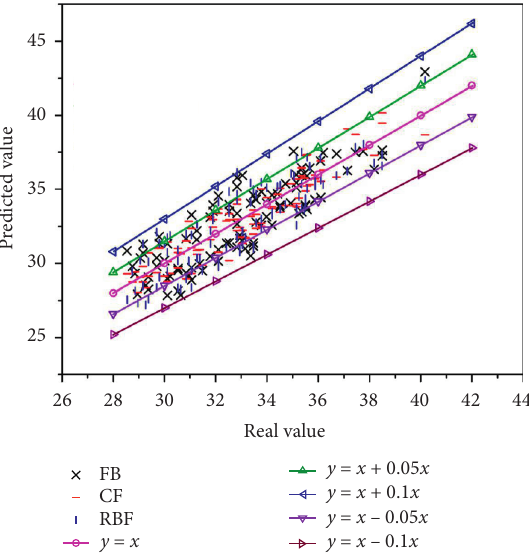
Figure 8: Comparison of prediction errors of CRI. d .